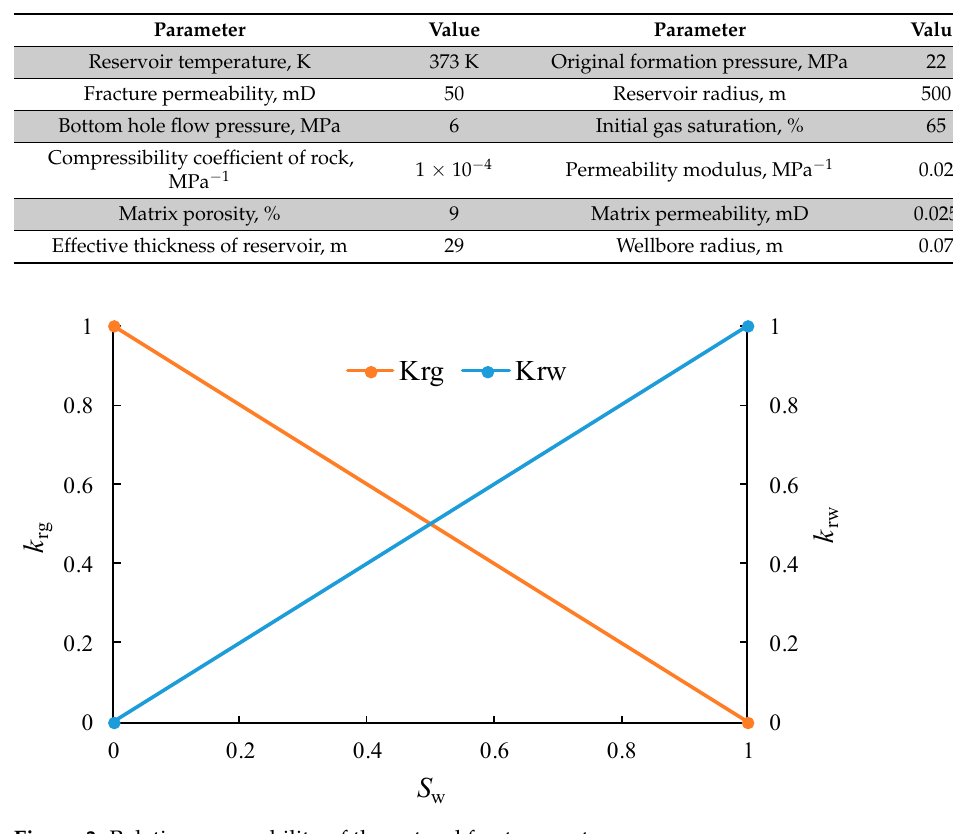
Figure 2. Schematic of the gas PVT properties. Table 1. Input parameters for model validation.